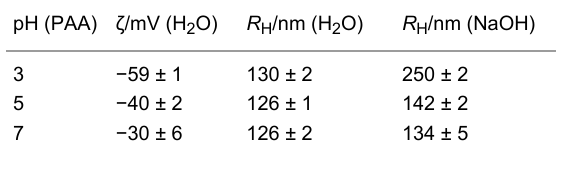
Table 1: Zeta potential ( ζ ) and hydrodynamic radii ( R H ) of PAA-coated PLGA-PEI nanoparticles in dependence on pH during PAA adsorption. Nanoparticle radii were obtained in ultrapure water (H 2 O) and 1 mM sodium hydroxide solution (NaOH), respectively. All experiments were performed in triplicate, average values ± standard deviations are shown.